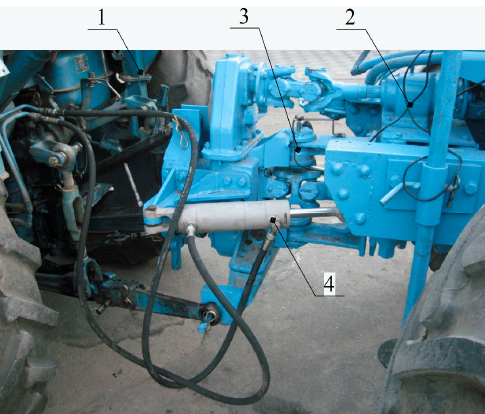
Figure 2. The connection of the power and the technological modules. 1—the power module; 2—the technological module; 3—the articulated joint; 4—the hydraulic cylinder, connecting the modules. Thus, the limited turning ability of the technological module 2 relative to the power module 1 in the horizontal plane at ±30° through the above articulated joint 3 is provided by the hydraulic cylinder 4, the above-piston and the sub-piston cavities of which are interconnected. The hydraulic system of cylinder 4 is equipped with a throttle (Figure 2).